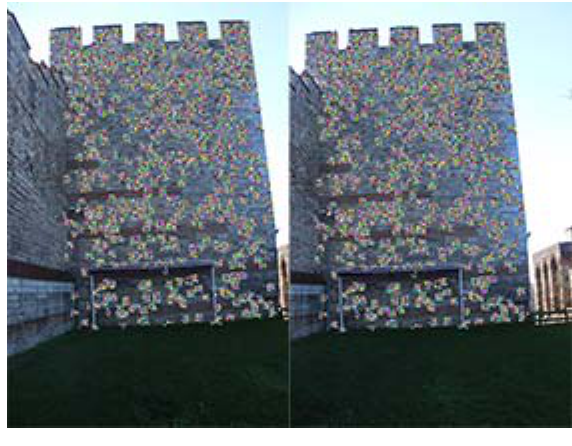
Figure-4 Ground control point plan